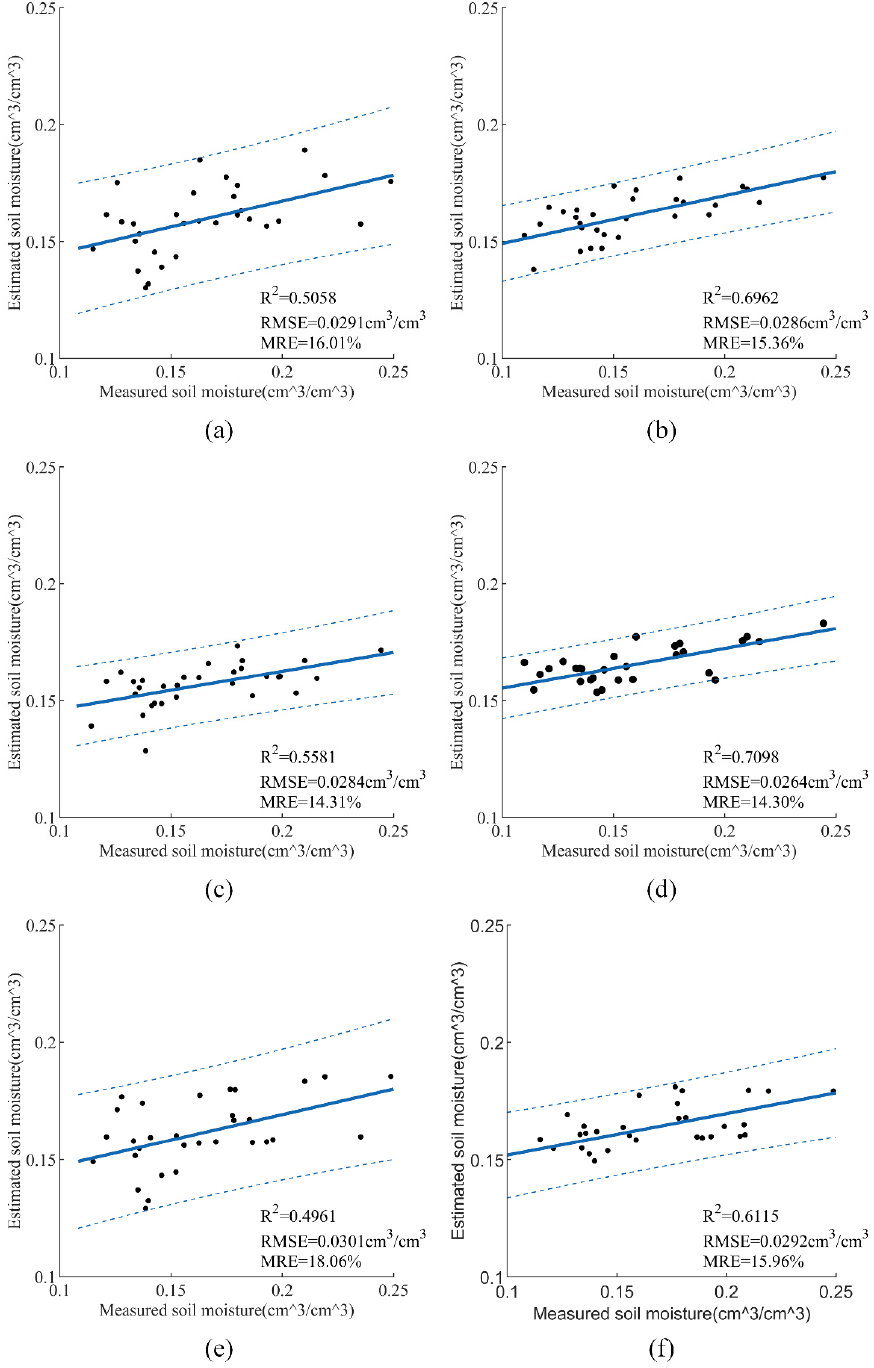
Figure 8. SMC retrieval results of the generalized regression neural network (GRNN) model with different feature combinations: ( a ) (cid:2026) (cid:3023)(cid:3009)(cid:2868) + (cid:2026) (cid:3023)(cid:3023)(cid:2868) + DEM + LIA + NDVI, ( b ) (cid:2026) (cid:3023)(cid:3009)(cid:2868) + (cid:2026) (cid:3023)(cid:3023)(cid:2868) + DEM + LIA +